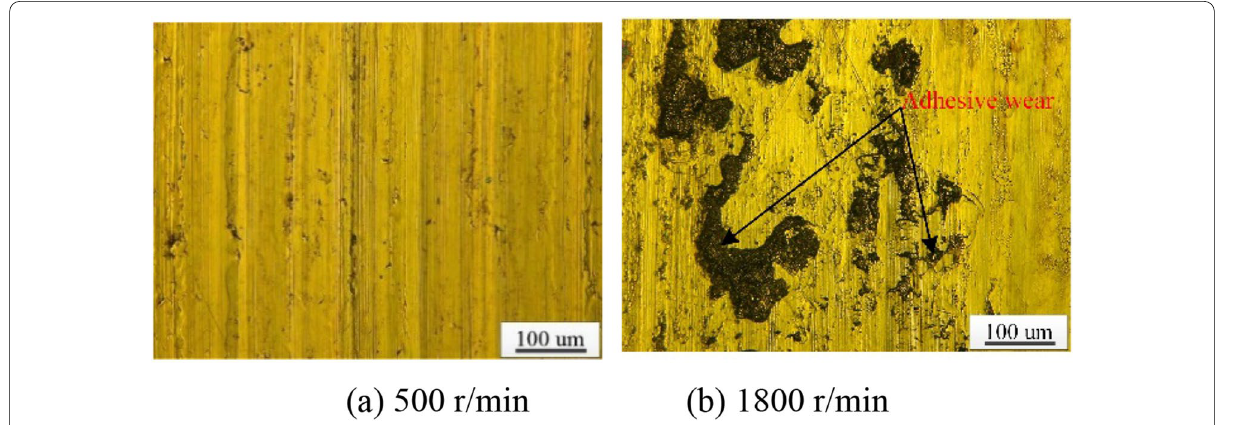
Figure 10 Surface morphology of the upper